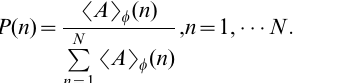
Figure S1 Stimulus-enhanced theta wave as well as CFC in a sparsely connected network with N EX = 100, N INf = 50, N INs = 50, and the probability of connection p =0.8. (A) The firing behaviors of single INs, INf and EX neurons. The bottom trace is the firing pattern of 50 EX neurons. (B) The response of the LFP to a stimulus lasting 500 ms and correspondent time-dependent power spectrum of the LFP. (C) Coherence of CFC between theta phase and the gamma amplitude for the pre and during stimulus epochs. (TIF) Figure S2 The corresponding figures in Fig.S1 for N EX = 200, N INf = 100, N INs =100, and the probability of connection p =0.6. The corresponding weights of connections are as follows: g GAfe = 0.015; g GAse = 0.06, g NMee =0.002, g NMes =0.0003, g AMee =0.007, g AMef =0.08, g NMef = 0.003, g GAff = 0.08, g GAfs = 0.0, g GAsf = 0.1, g AMes =0.005, g GAss = 0.08. (TIF) Figure S3 Effects of increasing only NMDA receptor (gNMee and gNMes) strengths in a sparse network on (A) theta and gamma amplitude, (B) the coherence of CFC between theta phase and gamma amplitude and (C) the variation of theta-band phase. (TIF) Figure S4 Dependence of theta amplitude and gamma amplitude (A), the coherence of CFC (B) and the variation of theta-band phase (C) on the EX-to-EX connection mediated by NMDAR and the Ins-to-EX connection mediated by slow GABAA receptors. (TIF) Figure S5 Increasing theta-gamma coupling without a corresponding change in theta amplitude by appropri- ately increasing the couplings g GAfe , g GAff and g GAsf together. In (A1–C1), to mimic the learning effects, the values of the couplings (gGAfe, gGAff,gGAsf) are chosen as: (0.007, 0.03,0.02) for 1st, (0.01,0.05,0.02) for 2nd, (0.015,0.06,0.035) for 3rd, and (0.02, 0.07, 0.04) for 4th. In (A2–C2), the theta and gamma amplitudes, the coherence of CFC and the phase variation are plotted vs. the stimulus strength. The black curve corresponds to before learning with (gGAfe, gGAff, gGAsf) = (0.007,0.03,0.02), the pink one corresponds to after learning with (gGAfe, gGAff, gGAsf) = (0.015,0.06,0.03). (TIF) Text S1 Supporting material: Results in a sparse network.